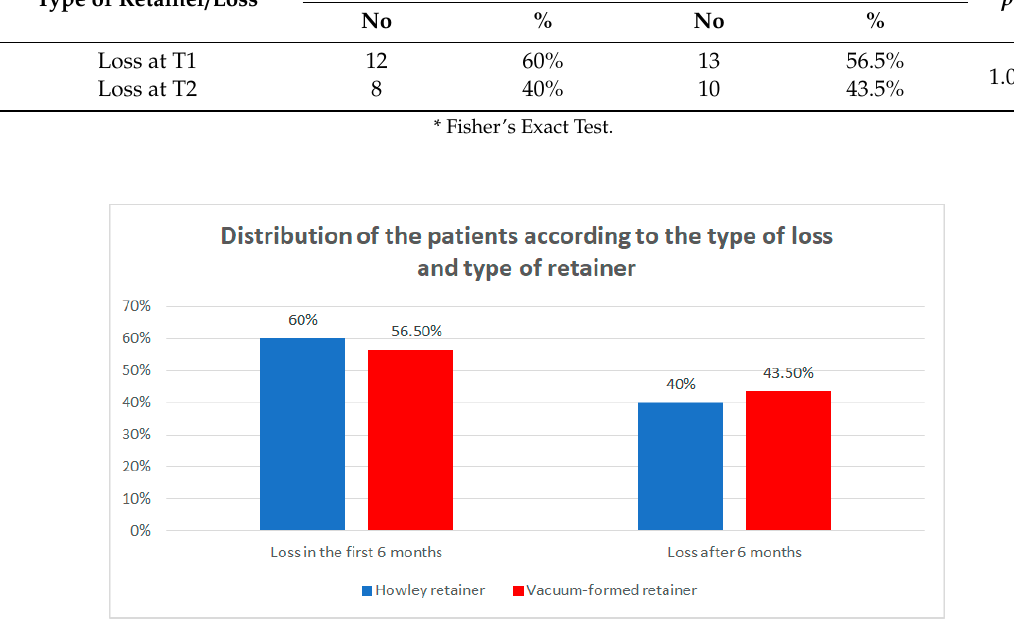
Figure 8. Distribution of the patients according to the type of loss and type of retainer.